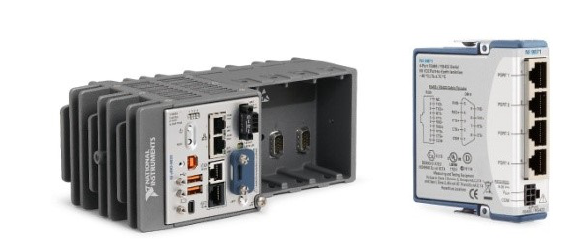
Figure 3. cRIO controller and NI-9871, RS-485 module